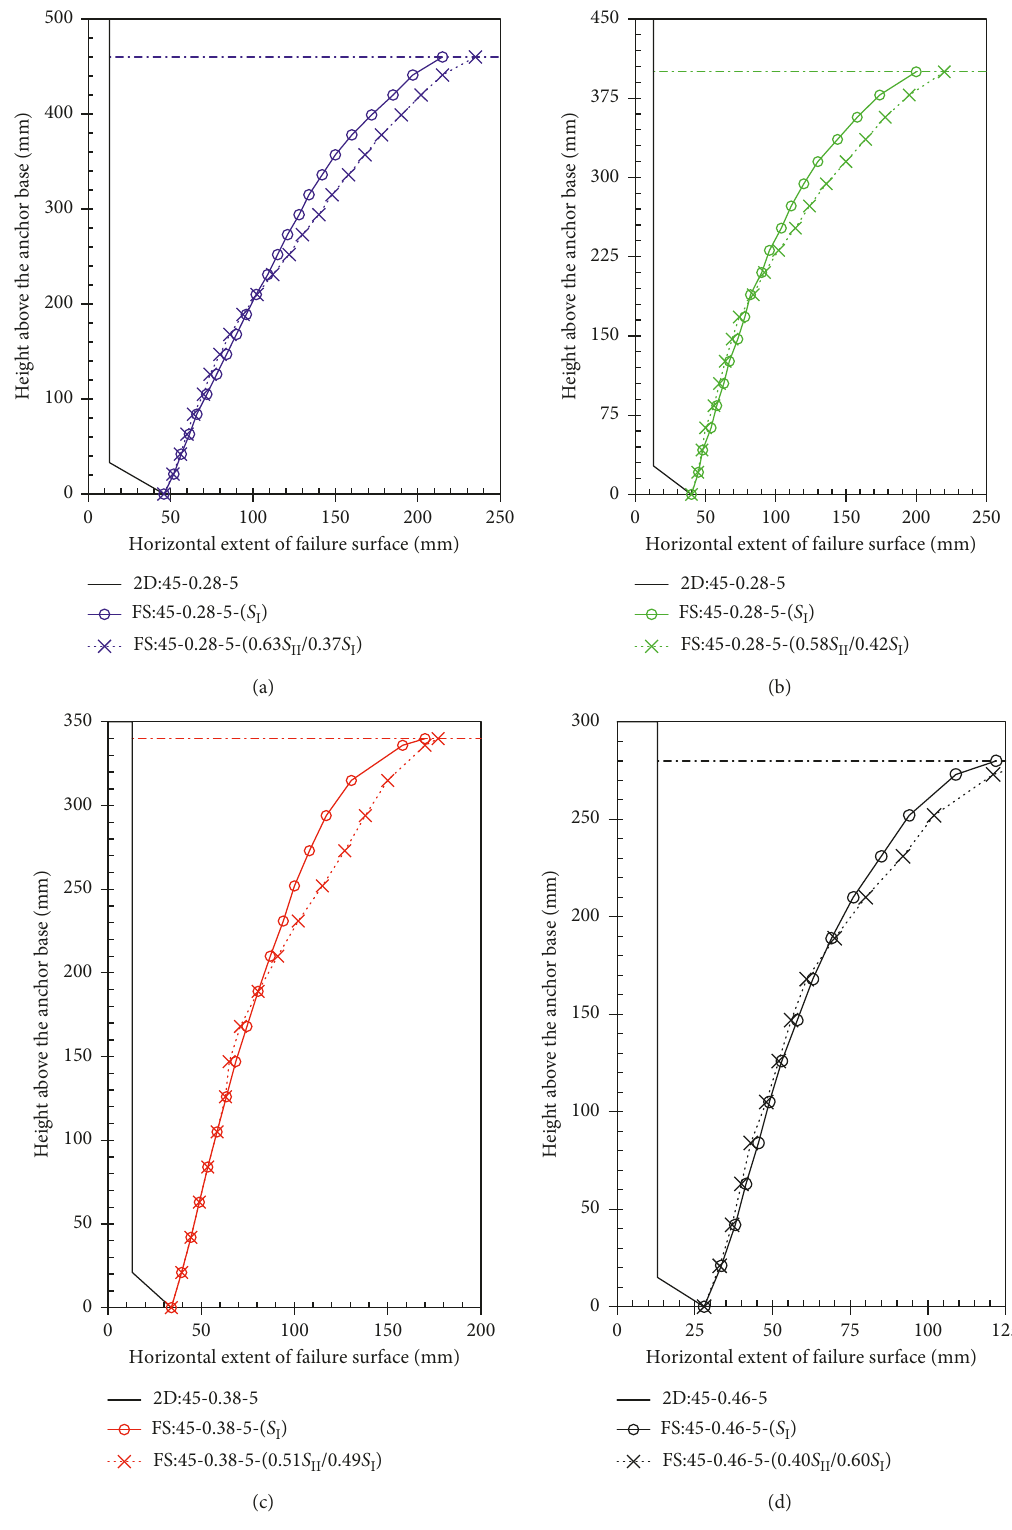
Figure 11: Comparison of (a) FS:45-0.28-5-( S I ) and FS:45-0.28-5-(0.63 S II /0.37 S I ), (b) FS:45-0.33-5-( S I ) and FS:45-0.33-5-(0.58 S II /0.42 S I ), (c) FS:45-0.38-5-( S I ) and FS:45-0.38-5-(0.51 S II /0.49 S I ), and (d) FS:45-0.46-5-( S I ) and FS:45-0.46-5-(0.40 S II /0.60 S I